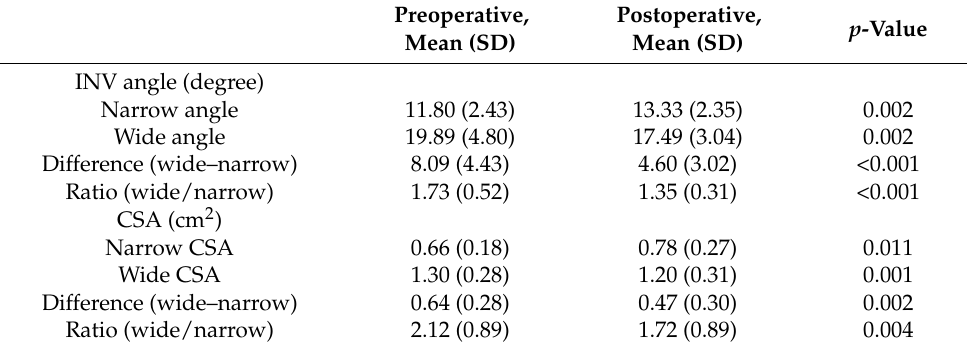
Table 2. Comparison of the preoperative and postoperative mean of the INV angle and CSA.